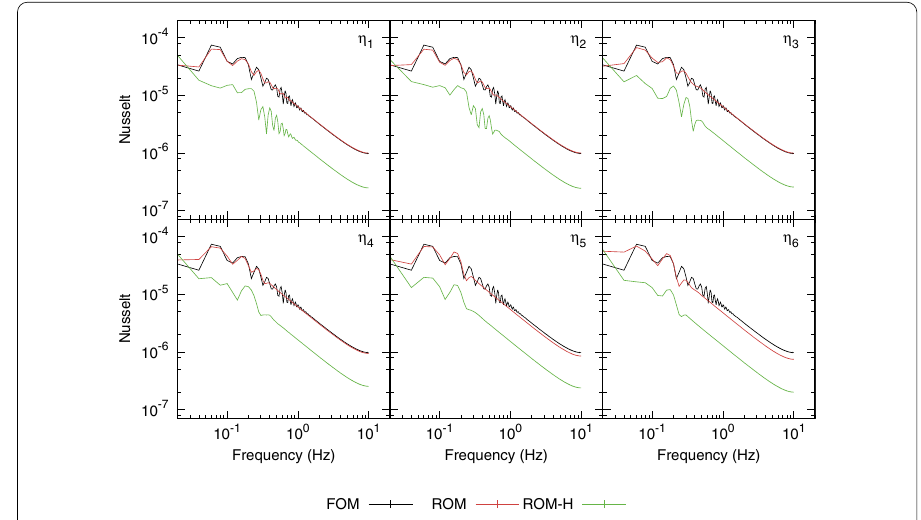
Fig. 13 Fourier transform of the Nusselt number for the hot wall